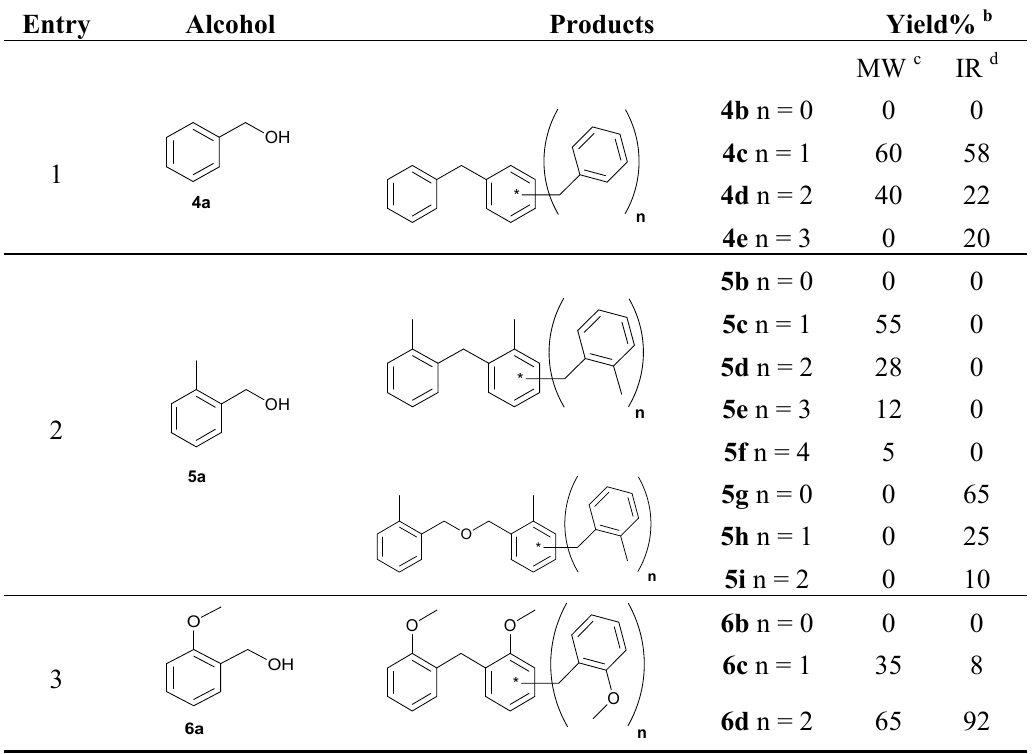
Table 2. Synthesis of oligotoluenes using two different heating models: MW and IR a . Entry Alcohol Products Yield% b